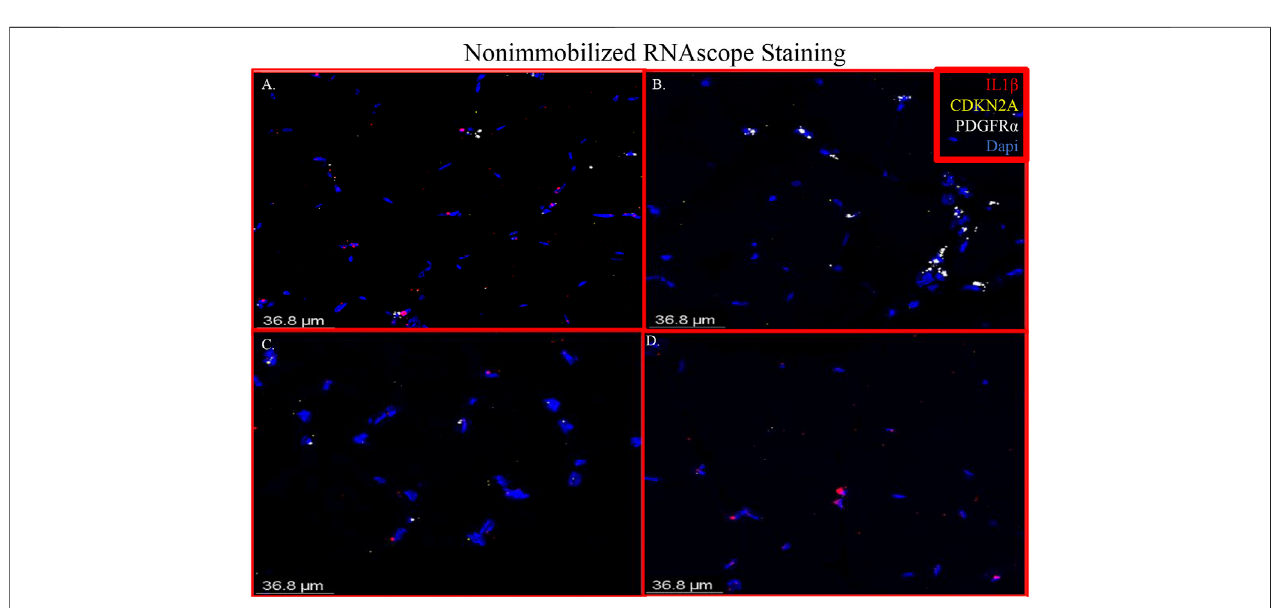
FIGURE 6 | Merged RNAscope images of nonimmobilized muscle. The merged RNAscope images of the nonimmobilized muscle counterparts to Figure 5 . The sameprobesforIL-1 β (red),Cdkn2a(yellow)andPDGFR α (white)areused.PanelAcorrespondstorowoneof SupplementaryFigureS2 ,PanelBtorow2,PanelCto row 3 and Panel D to row